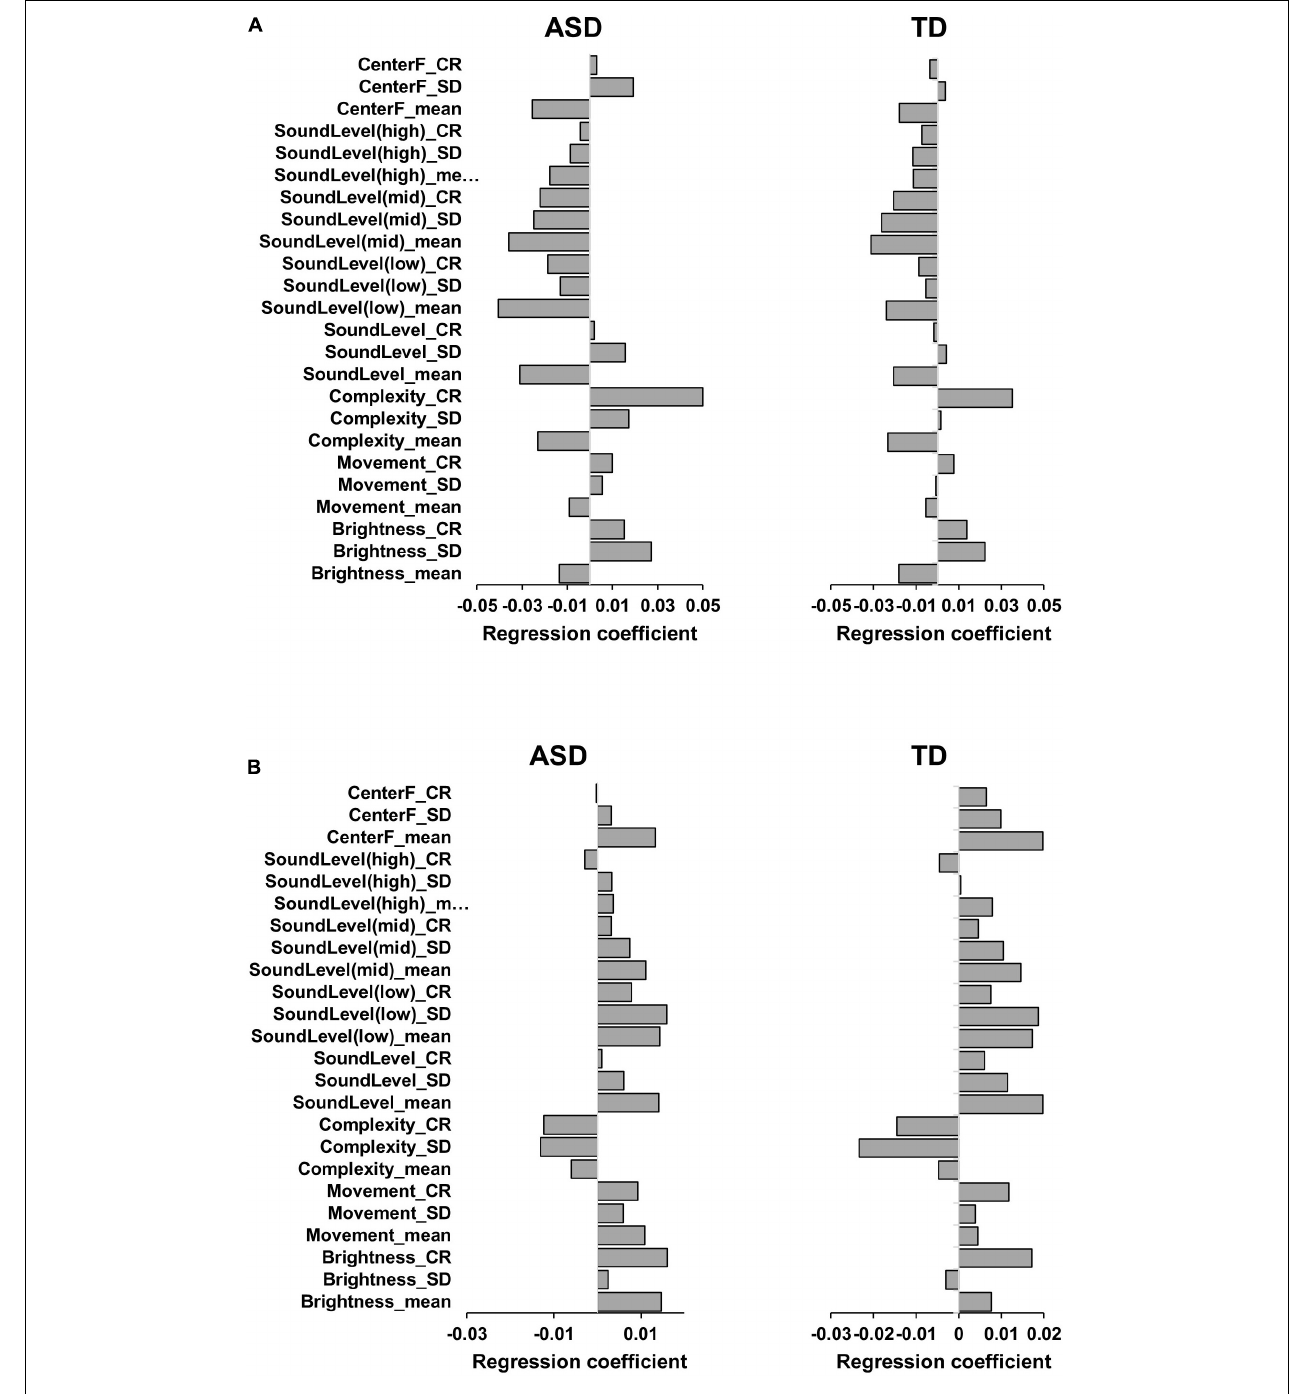
FIGURE 4 | The regression coefficients of the principal component regression models for the amplifier (A) and noise perception (B) . SD, CR, and centerF mean standard deviation, changing rate, and sound center frequency, respectively.